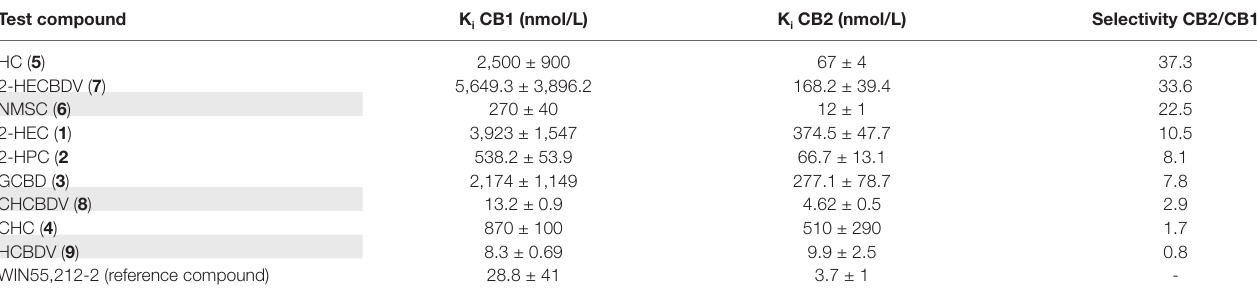
TaBlE 3 | Inhibition constants (K i ) and selectivity of test compounds for CB1‑ and CB2‑receptors in the order of their selectivity for CB2‑receptors. K i values are expressed as the mean ± SEM of n = 3 independent experiments. Test compound